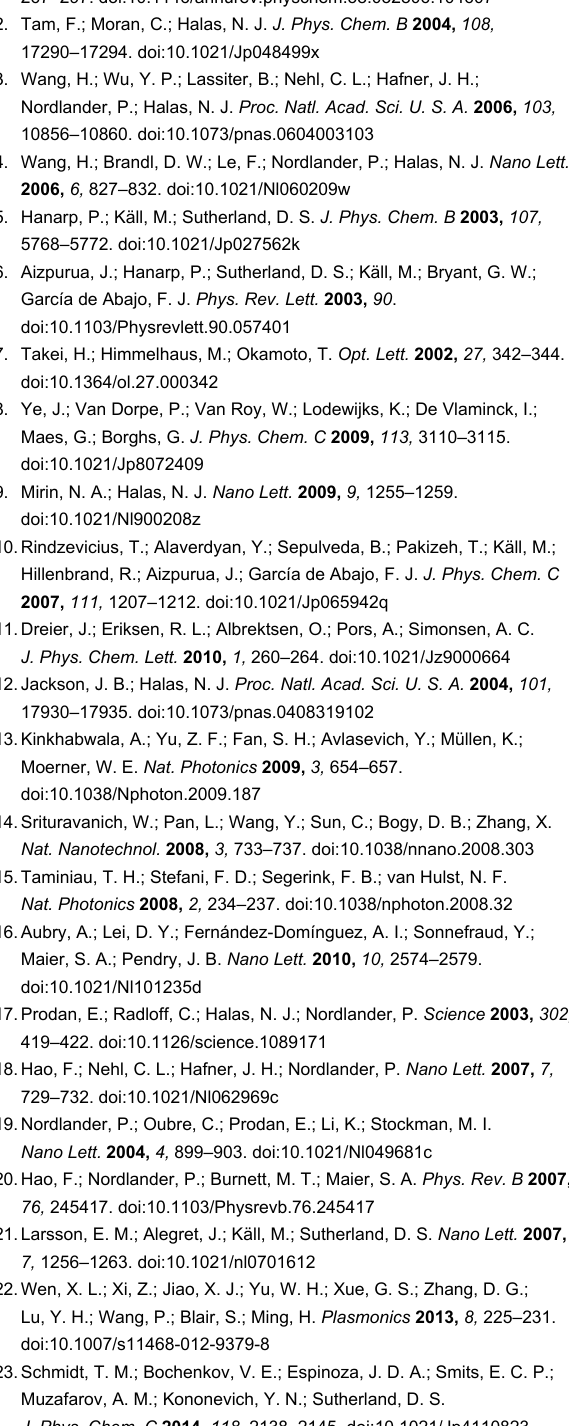
been used in recent work to enhance optical processes [22] . We provide a detailed description of the modes, interestingly identi- fying bonding between the caps and both bright symmetric and dark antisymmetric SPP modes. The coupling of LSPR modes to dark anti-symmetric SPP modes has not to our knowledge been previously reported. The coupling present in this simple to fabricate system can be used both to study dark SPP modes and/or for rational design of sensors through plasmon enhance- ment of optical processes (e.g., SERS or SEF) and/or engi- neering of the near field (lifting the SPP modes out of the sub- strate) for refractive index